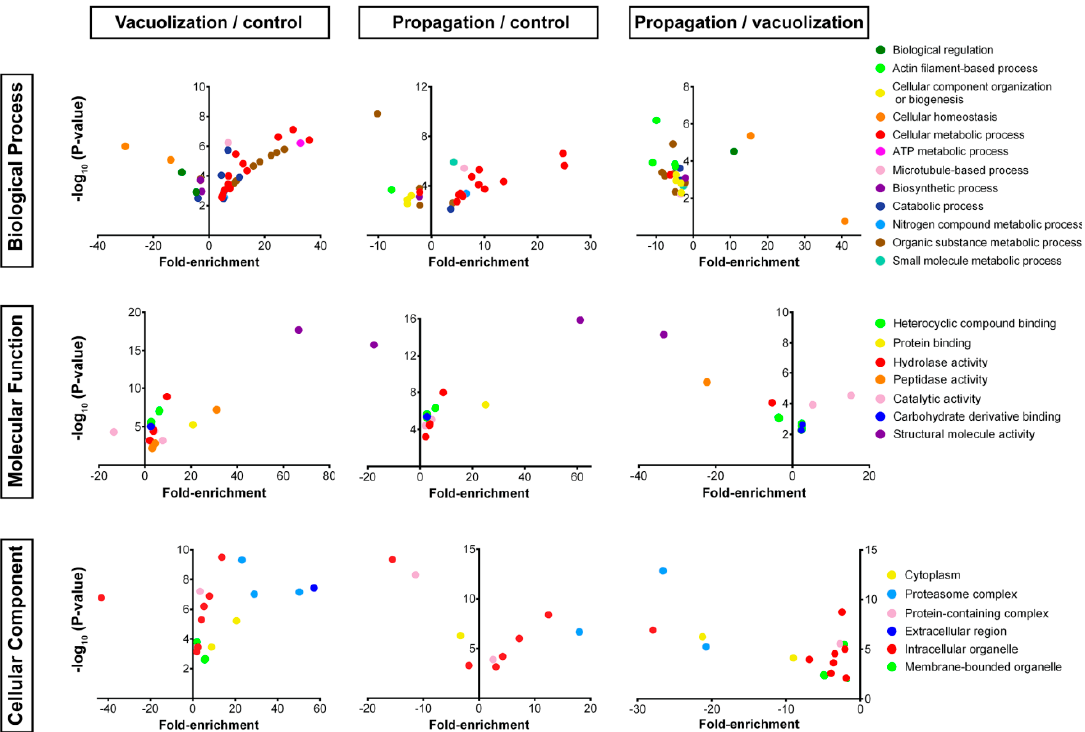
Figure 5. Enrichment analysis of S. salar proteins in SHK-1 infected and uninfected cells. Gene ontology (GO) terms were assigned to the proteins identified by quantitative proteomics, and the resulting GO were compared to S. salar proteome (reference). Proteins with assigned GO were quantified and each GO is shown as fold-enrichment. For each comparison (vacuolization vs. control, propagation vs. control, and propagation vs. vacuolization), significantly upregulated proteins (log 2 ratio ≥ 0.6) or downregulated proteins (log 2 ratio ≤ − 0.6) were used for enrichment analysis. Positive values indicate over-represented categories, and negative values under-represented categories for each comparison (indicated with rectangles at the top). Over- or under-represented GO with FDR < 0.05 are shown.